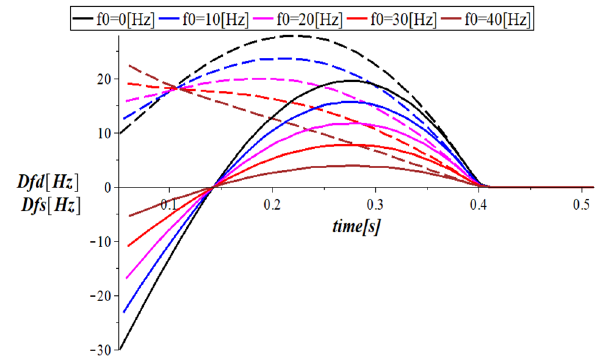
Fig. 5 Electric current in R,L circuit for linear voltage frequency increase, according to (4)